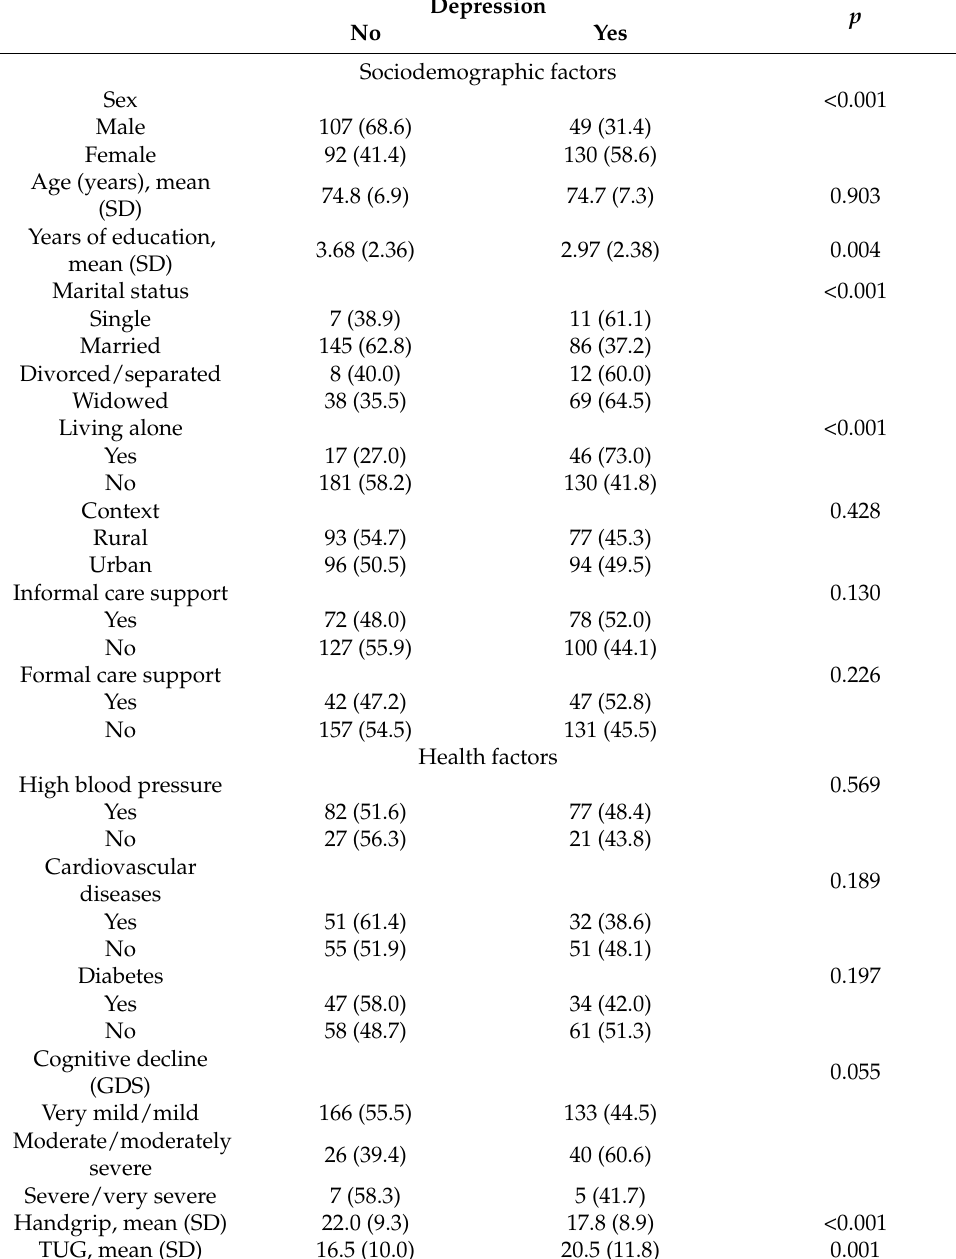
Table 3. Association between major depressive disorder and sociodemographic, health, and be- havioural